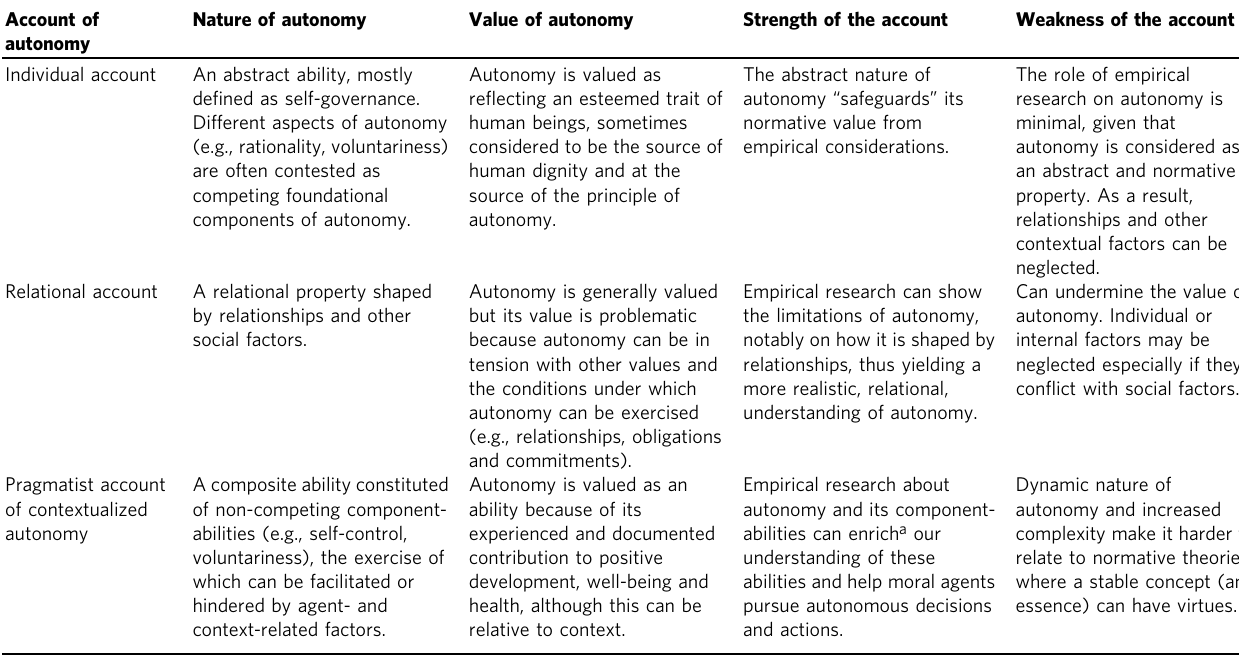
Table 1 Comparative overview of different accounts of